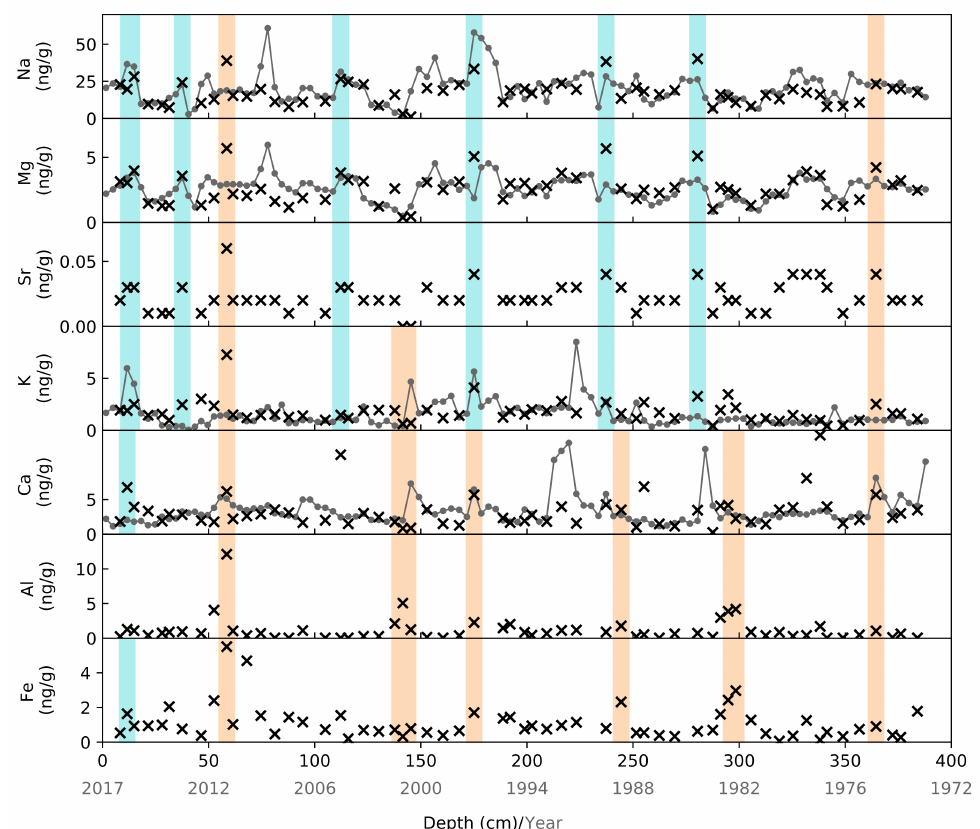
Figure 4. Concentration vs. depth profiles of (in order from top to bottom): Na, Mg, Sr, K, Ca, Al and Fe. Light blue stripes highlight recurrent peaks in the marine markers, while the light red stripes indicate recurrent peaks in the crustal markers. The solid lines specify the ions analyzed by IC, while the crosses indicate the elements analyzed by ICP-OES. The dating attributing is shown in the x label in